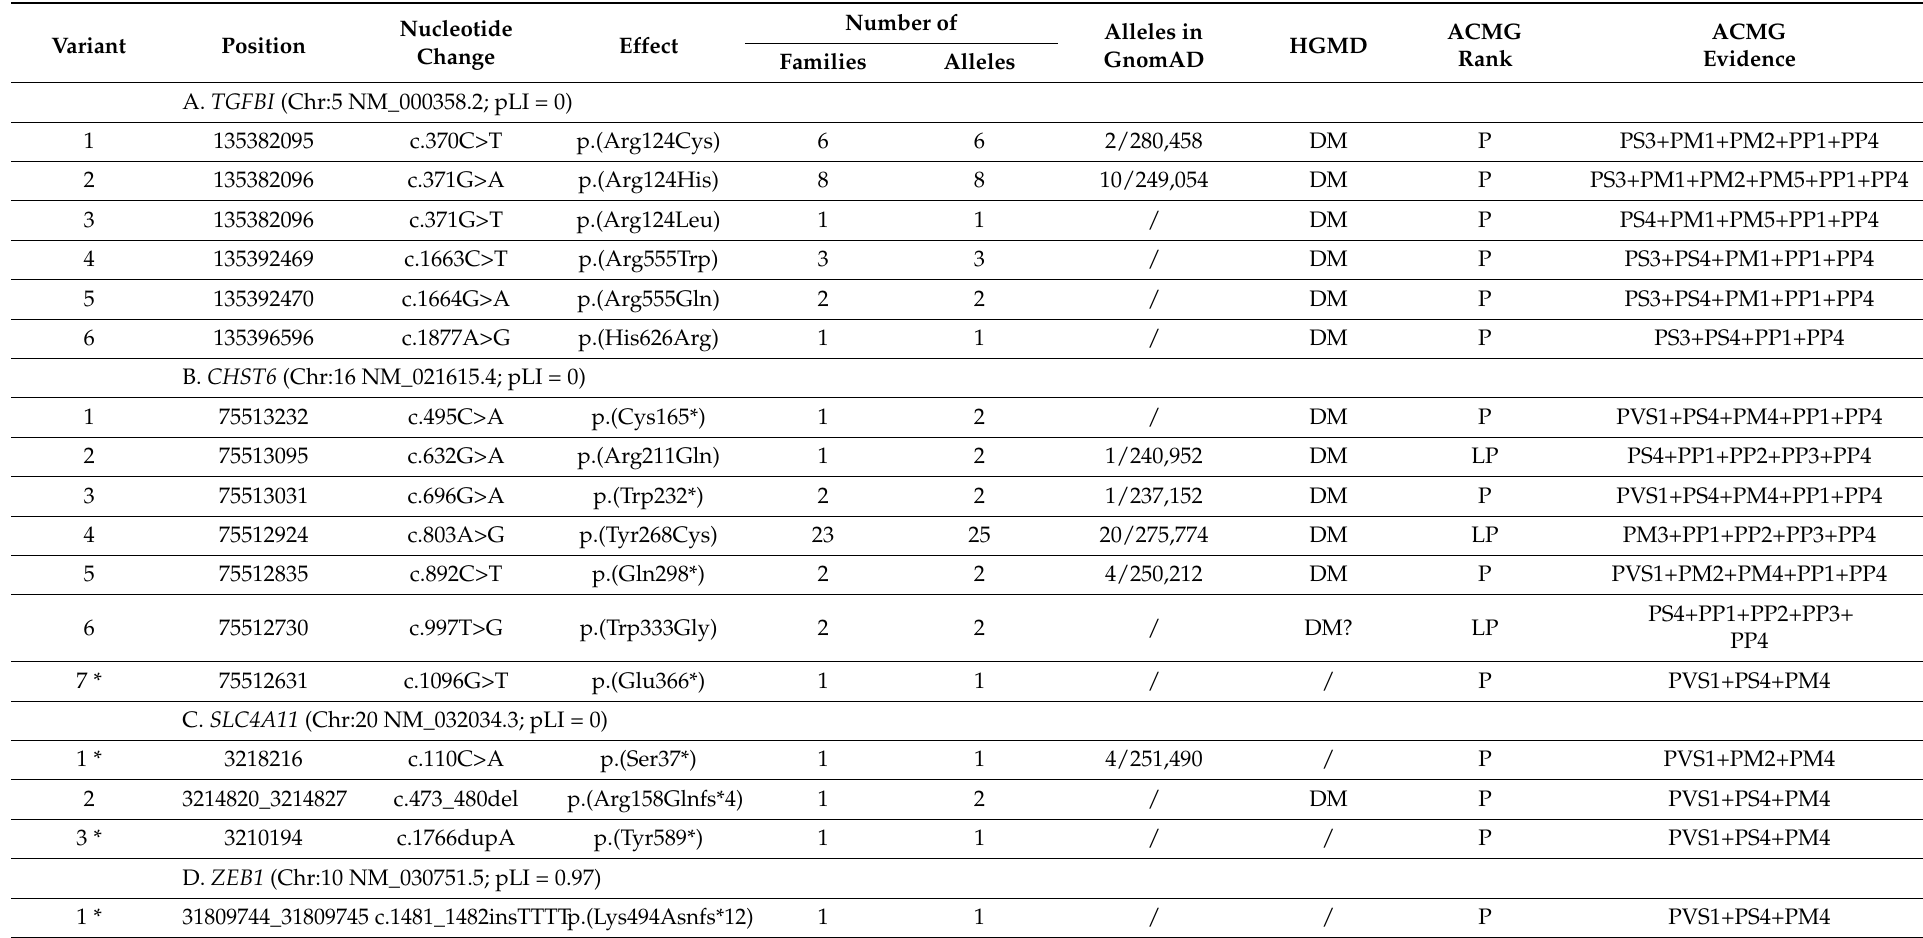
Table 1. Families with CD phenotype and pathogenic or likely pathogenic variants in TGFBI , CHST6 , SLC4A11 , or ZEB1 in current